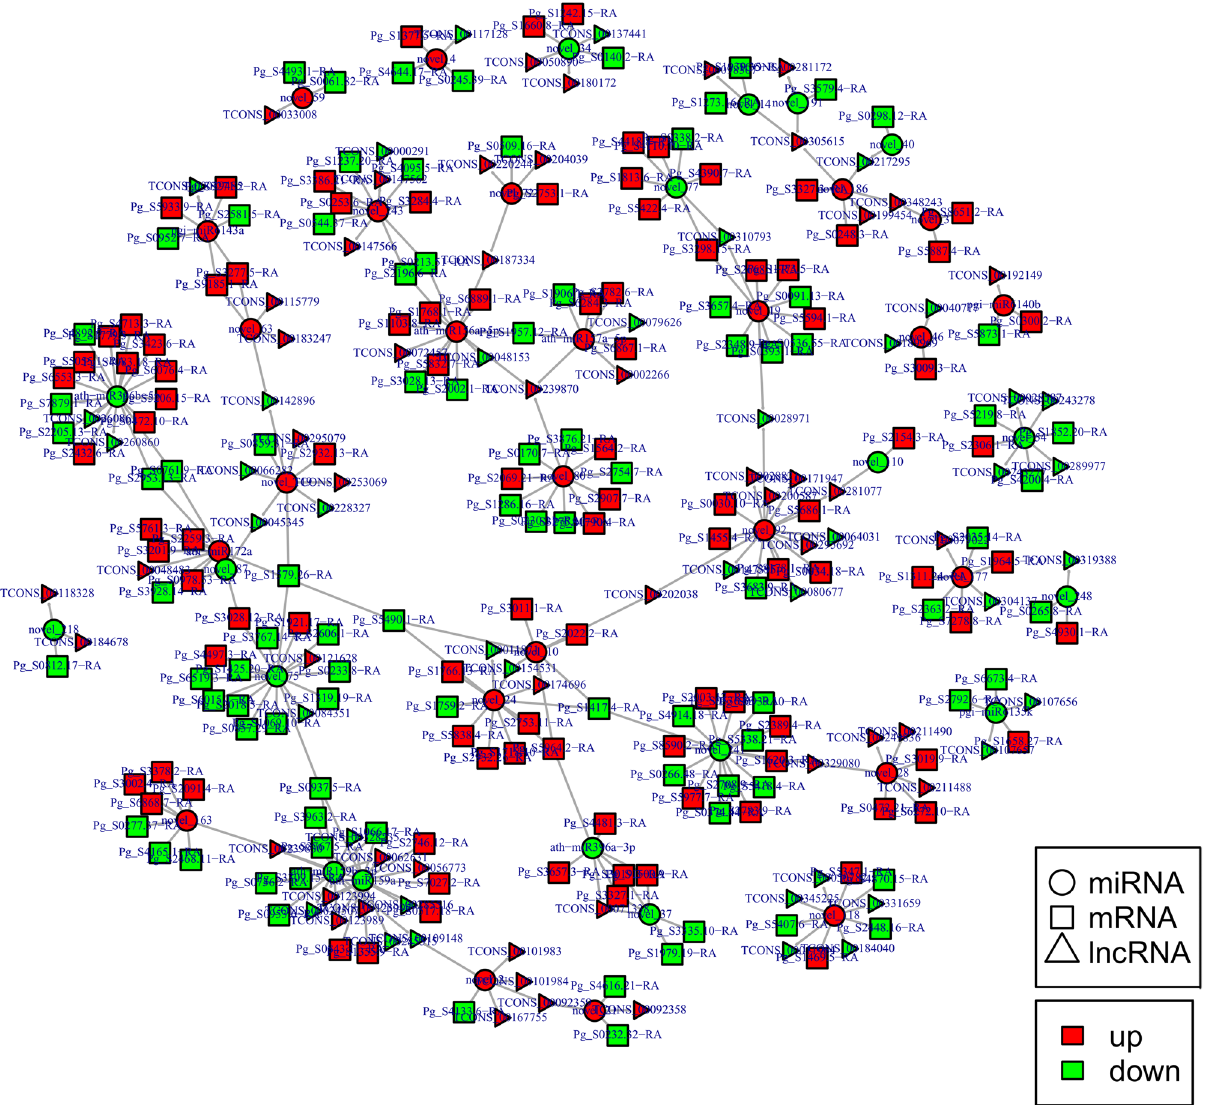
Figure 13. Interaction network of lncRNA-miRNA-mRNA in ginseng tissues. Network diagram made by Cytoscape sofware 3.8.2 (https:// cytos cape. org/) 57